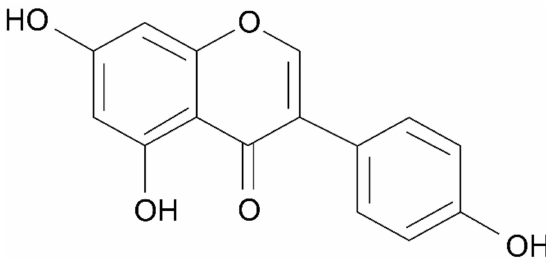
Figure 10. The chemical structure of